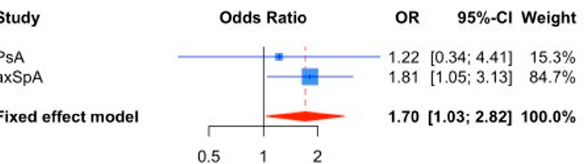
Figure 1. Forest plot of the meta-analysis based on a fixed-effect model performed by pooling the effect of smoking on disease activity.